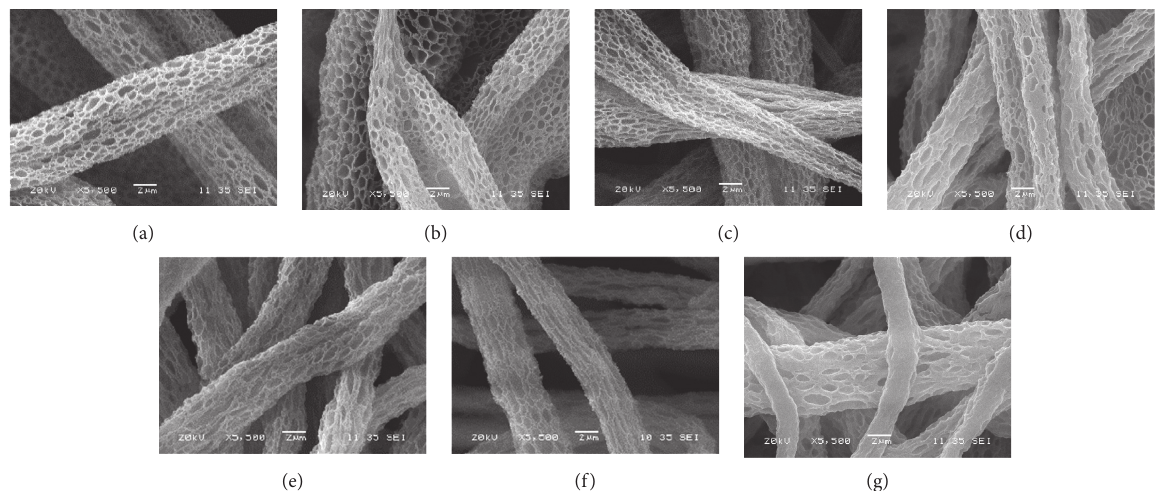
Figure 1: SEM micrograph comparison of the fabricated electrospun mats. (a) CA fiber mat, (b) CA-deacetylated, (c) CA-oxidized, (d) CA- KRSR, (e) CA-BMP-2, (f) CA-RGD, and (g)